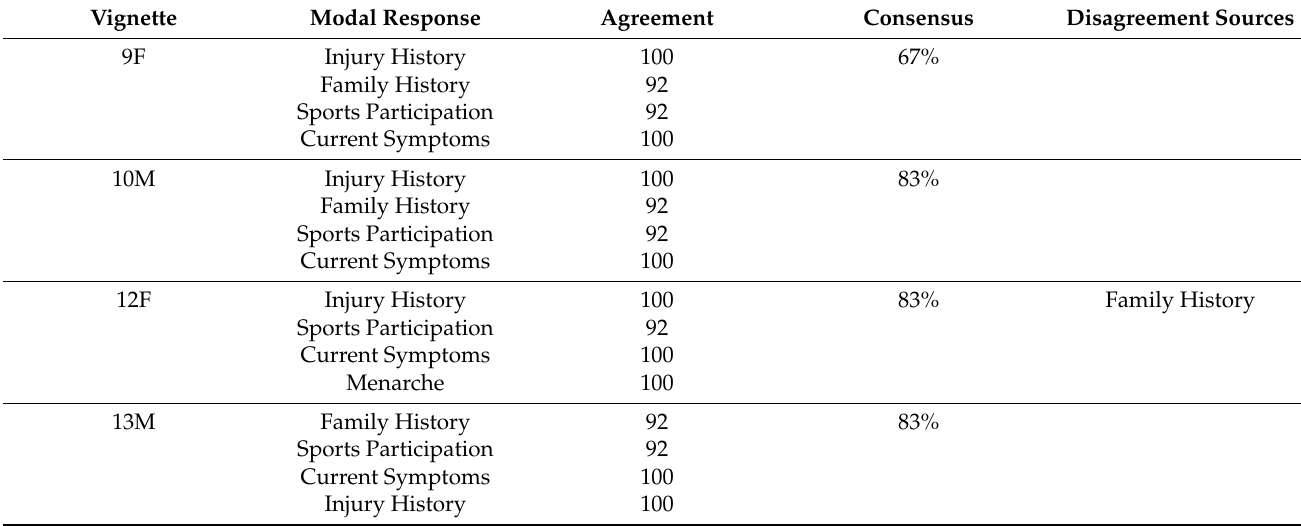
Table 1. Consensus reached regarding pertinent factors in patient history with relevant sources of disagreement per vignette.